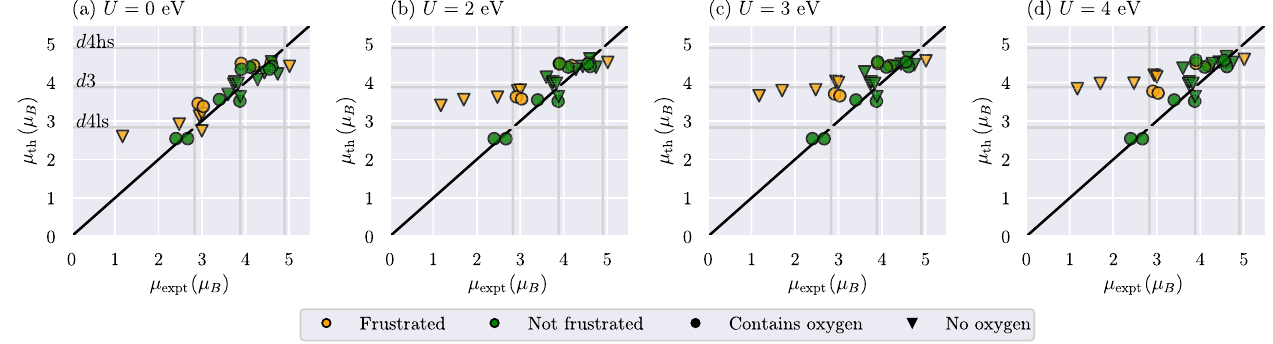
FIG. 7. Average magnetic moment per Mn site of the CMP þ SDFT þ U minimum most similar to the experiment with respect to its configuration μ compared to the experimentally measured magnetic moment per site μ th (d) U ¼ 4